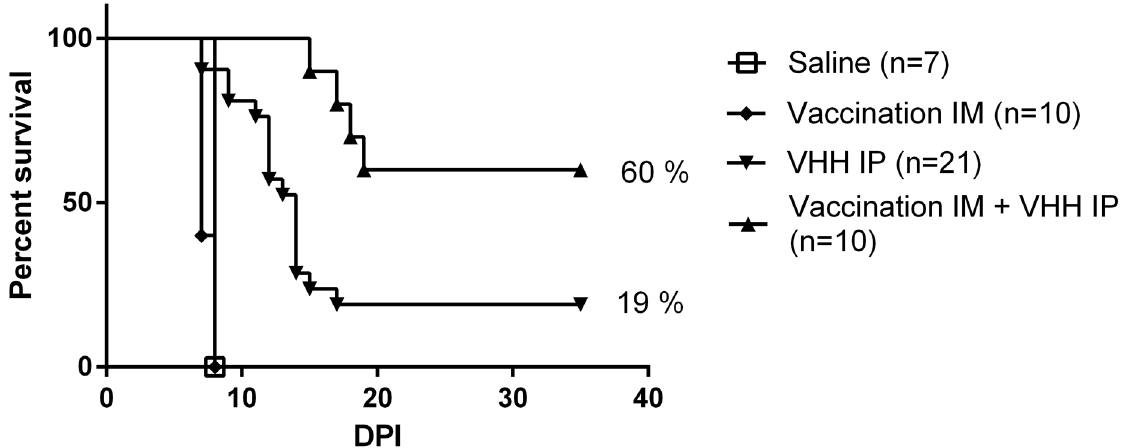
Fig 3. Effect of post-exposure prophylactic treatment with vaccine and anti-rabies VHH on survival in rabies mouse model. Mice were intranasally inoculated with rabies virus followed by treatment with anti-rabies VHH (IP) 24 hours later, either alone or in conjunction with vaccine (IM). Vaccinated mice received a second vaccine dose 3 days later. Control groups consisted of mice that were not treated (virus only group) or that received the vaccination regime only (vaccination group). Combined treatment with vaccine and anti-rabies VHH resulted in 60% survival, while treatment with anti-rabies VHH alone rescued 19% (p < 0.01).